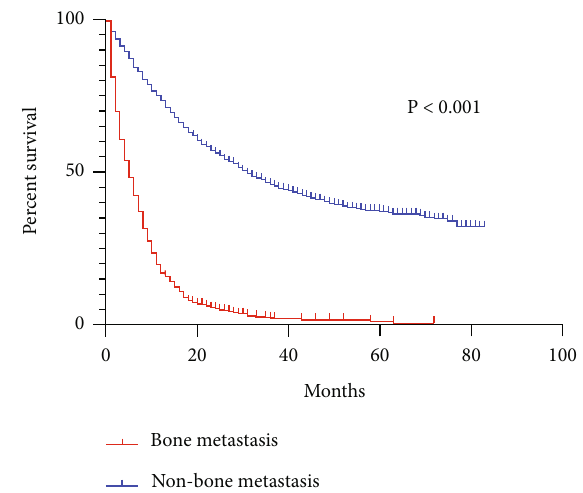
Figure 1: Overall 5-year survival rate of patients with gastric cancer bone metastasis and gastric cancer nonbone